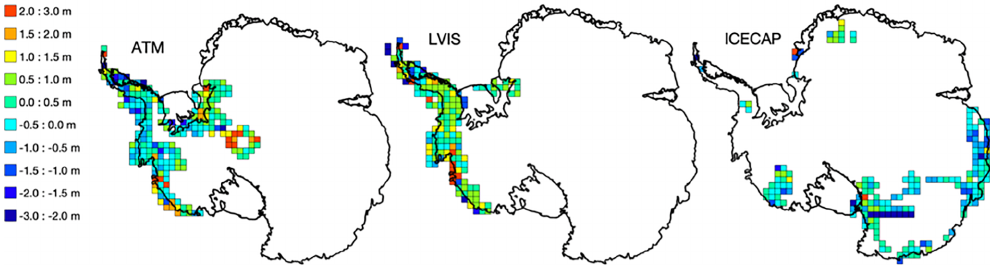
Figure 7. Median of elevation differences by mosaic tile between REMA and each of the three NASA Operation IceBridge lidar systems. Only measurements collected less than 1 year apart are